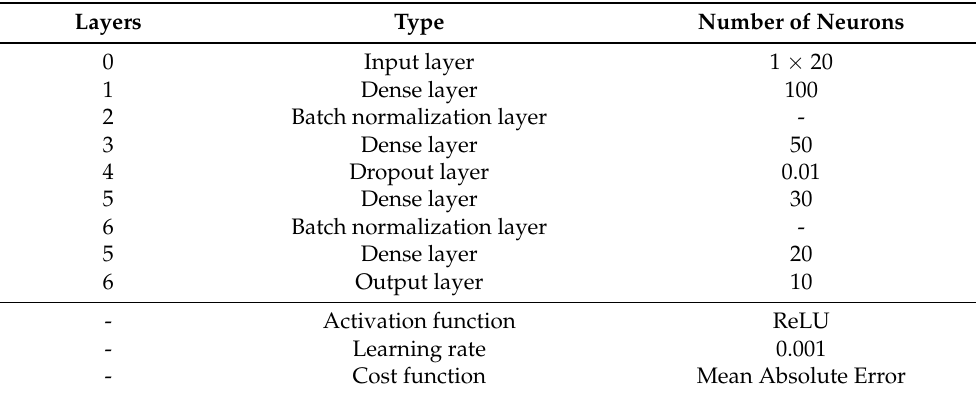
Table 2. DMLP model